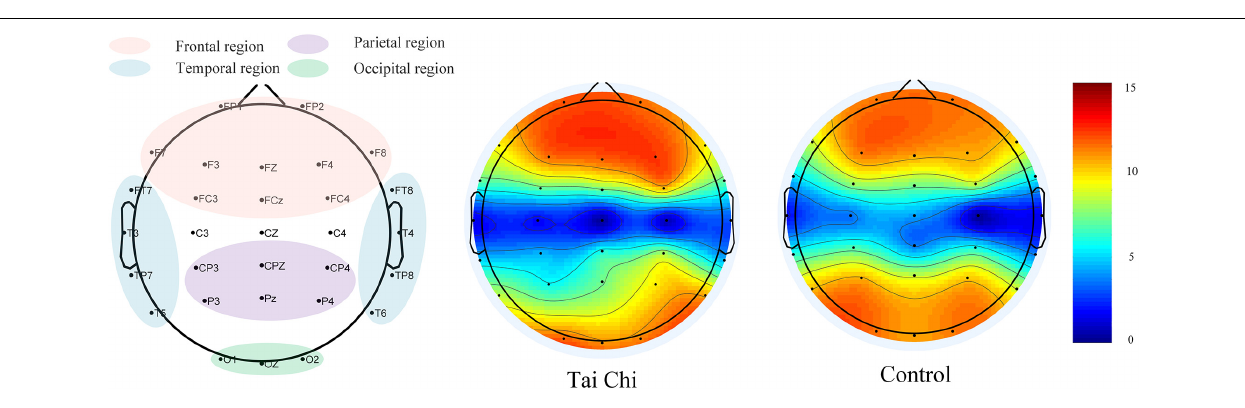
FIGURE 7 | Node location and node degree topographic